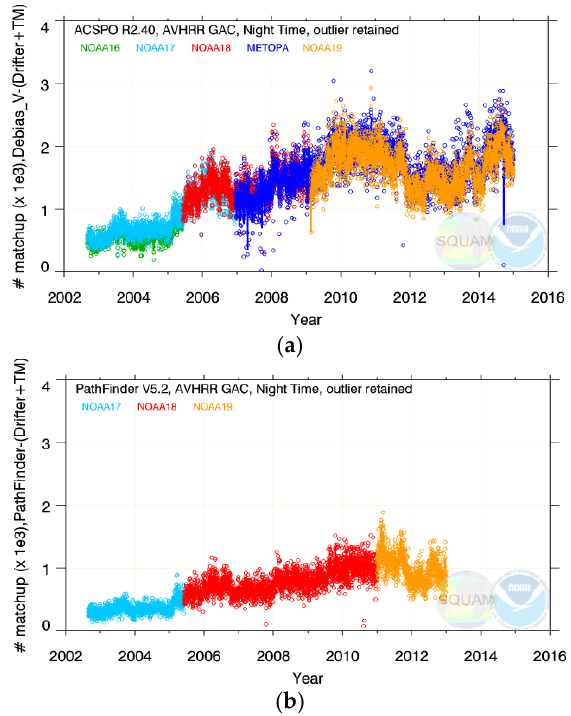
Figure 5. Number of daily matchups with in situ data used in producing Figures 3 and 4: ( a ) RAN1; ( b ) PFV5.2.